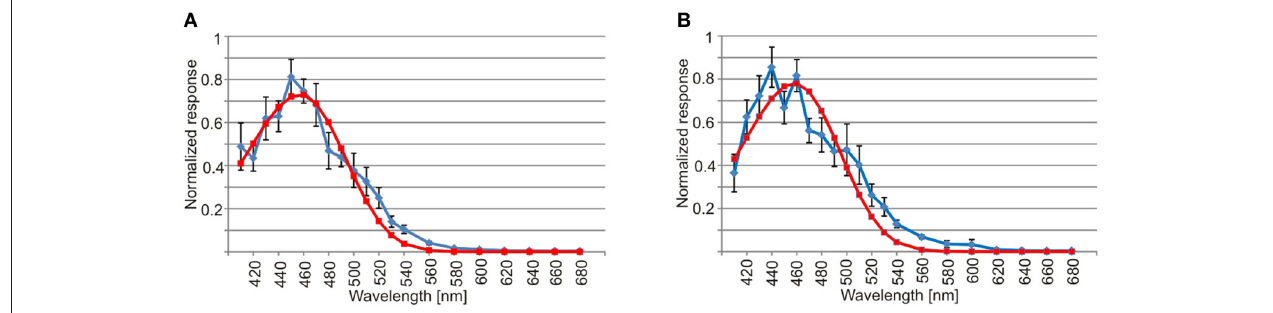
FIGURE 5 | Spectral sensitivity of the lens eye. (A) The spectral sensitivity curve of the upper lens eye (blue line) has a single peak in the deep blue part of the spectrum and has a good match with the absorption curve of a 458nm opsin (red line, AIC = − 53.7). (B) Similar to the upper lens eye the spectral sensitivity of the lower lens eye (blue line) peaks in the deep blue part of the spectrum and had a best match with a single opsin peaking a 458nm (red line, AIC = − 35.9). The curves are showing mean ± S.E.M., N =